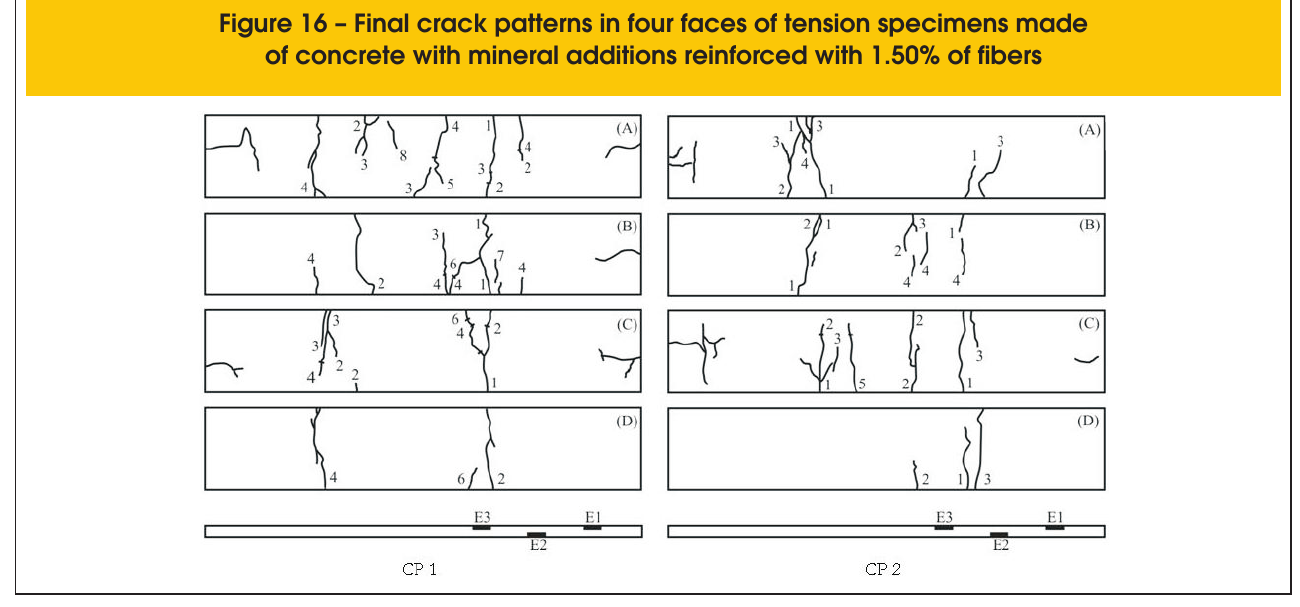
Figure 16 – Final crack patterns in four faces of tension specimens made of concrete with mineral additions reinforced with 1.50% of